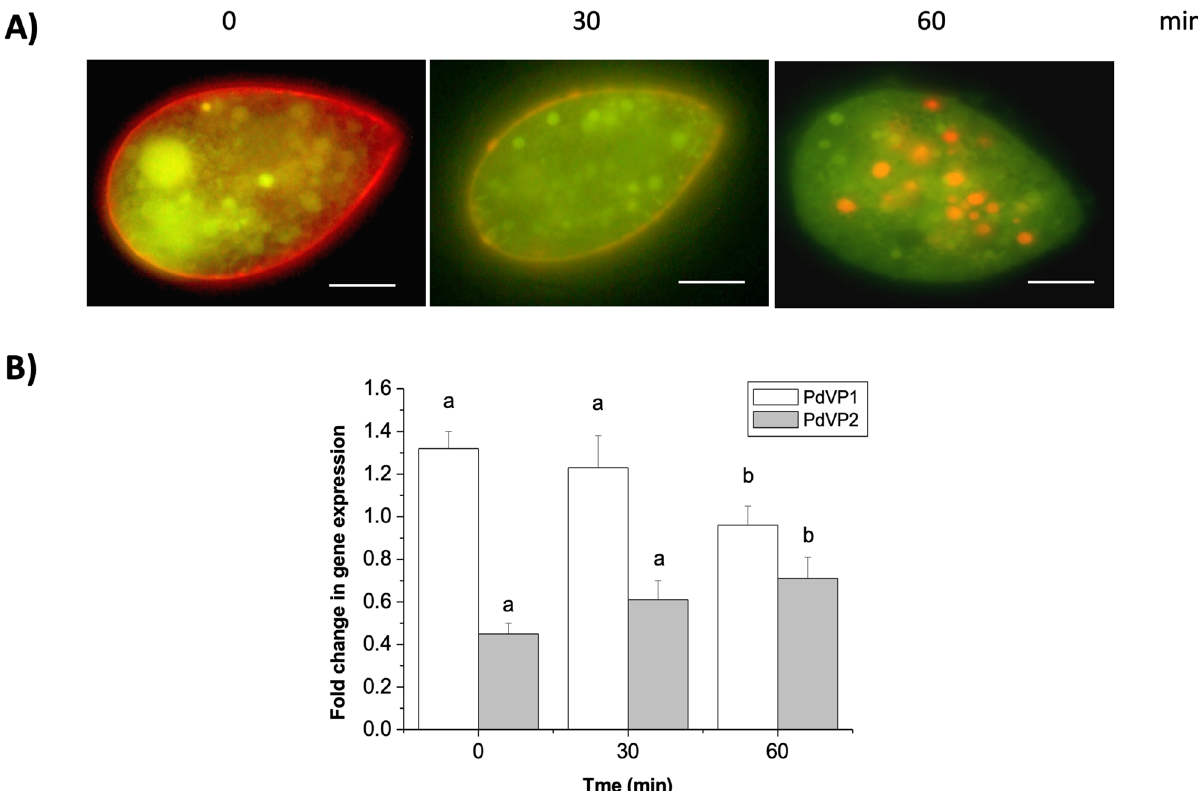
Figure 6. ( A ) Changes in the acidification kinetics of the alveolar sacs and cytoplasmic vacuoles after the addition of Tris-PPi (1 mM) and MgSO 4 (1.3 mM), and after 30 and 60 min (detected by fluorescence microscopy). An increase in acidification was detected by the change in fluorescence emission in the acridine orange stain from green (not acidified) to red (acidified). ( B ) Quantification of the expression of the H + -PPases (PdVP1 and PdVP2) obtained under the same conditions as ( A ). The bars express the mean values ± the standard error (SE) (n = 5) in the fold change in gene expression. The same and different letters indicate respectively the absence or presence of statistically significant differences ( P < 0.05) relative to the control (time 0). Scale bar = 10